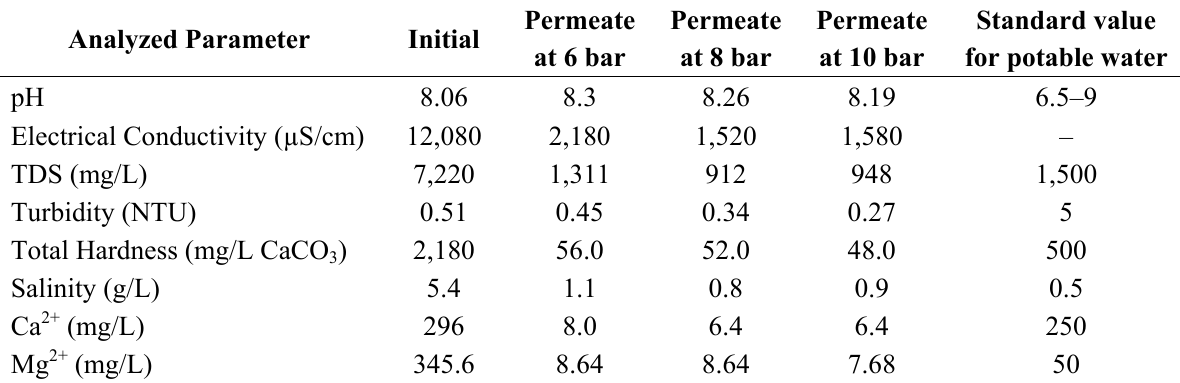
Table 2. Analysis of the feed and permeates at various pressures (Sample 2).